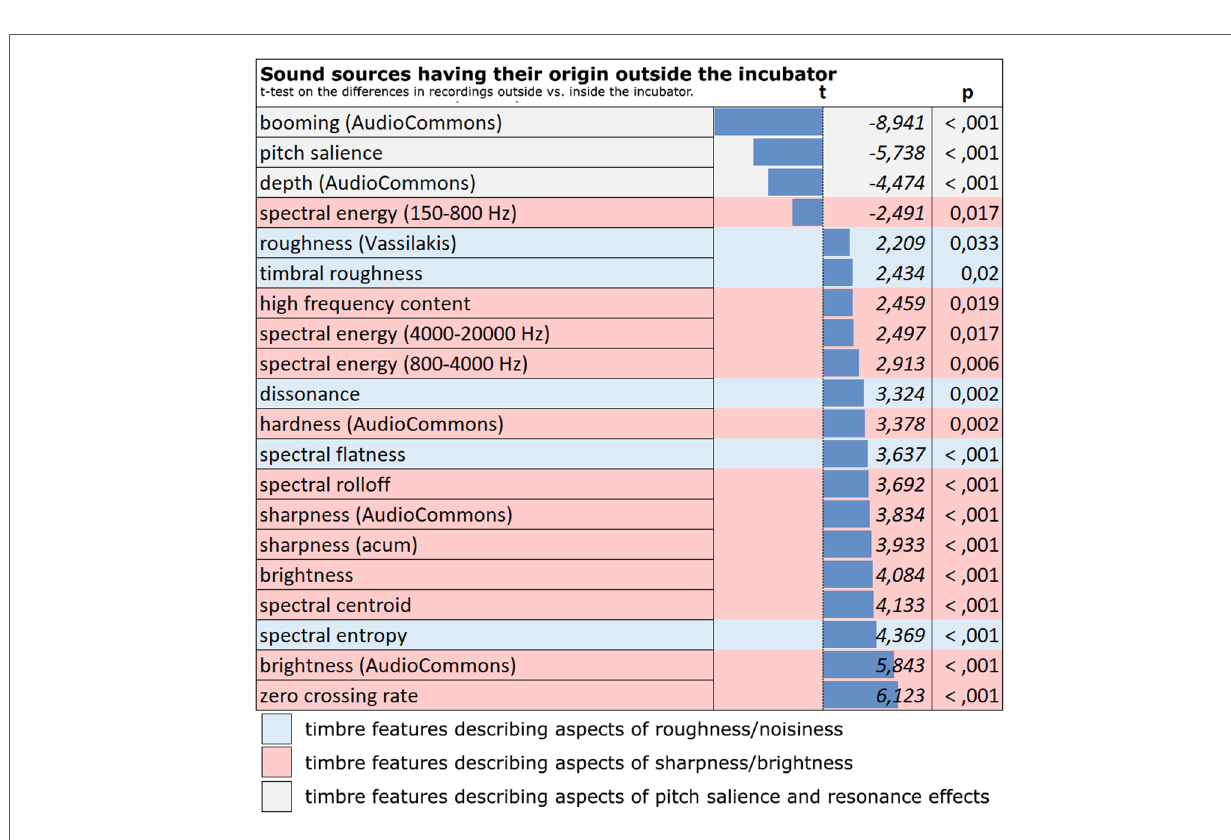
FIGURE 3 Noises from outside the incubator. Timbral differences between the recordings outside and inside of the incubator (marked red: timbre features describing aspects of sharpness/brightness; marked blue: timbre features describing aspects of roughness/noisiness, marked grey: timbre features describing aspects of pitch salience and resonance